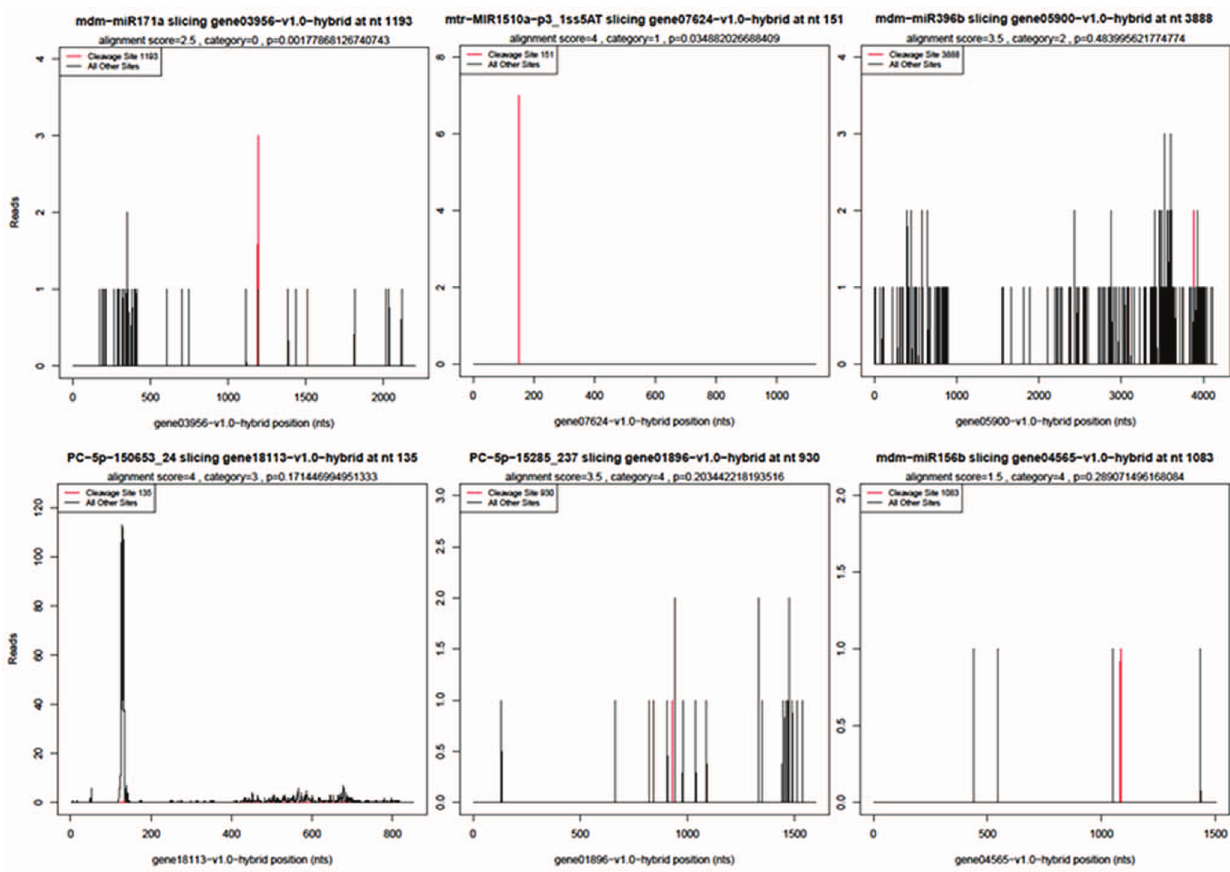
Figure 3. The T-plots of miRNA targets in the five different categories. T-plots show the distribution of the degradome tags along the full- length of the target mRNA sequence. The red line represents the sliced target transcripts. (A) Example of the category 0 target gene03956 2 v1.0 2 hybrid for mdm 2 miR171a. (B) Example of the category 1 target gene07624 2 v1.0 2 hybrid for mtr 2 MIR1510a 2 p3_1ss5AT. (C) Example of the category 2 target gene05900 2 v1.0 2 hybrid for mdm 2 miR396b. (D) Example of the category 3 target gene18113 2 v1.0 2 hybrid for PC 2 5p 2 150653_24. (E) Example of the category 4 target gene04565 2 v1.0 2 hybrid for mdm 2 miR156b and gene01896 2 v1.0 2 hybrid for PC 2 5p 2 15285_237. The categories were based on the relative abundance of the tags at the target sites.